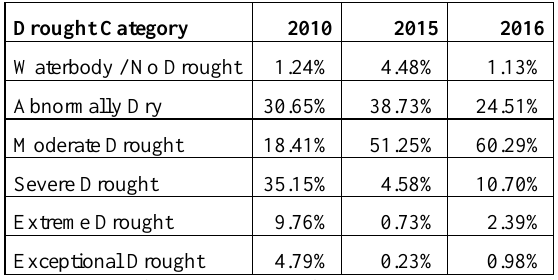
Table 2. Surface Distribution of Drought by category in